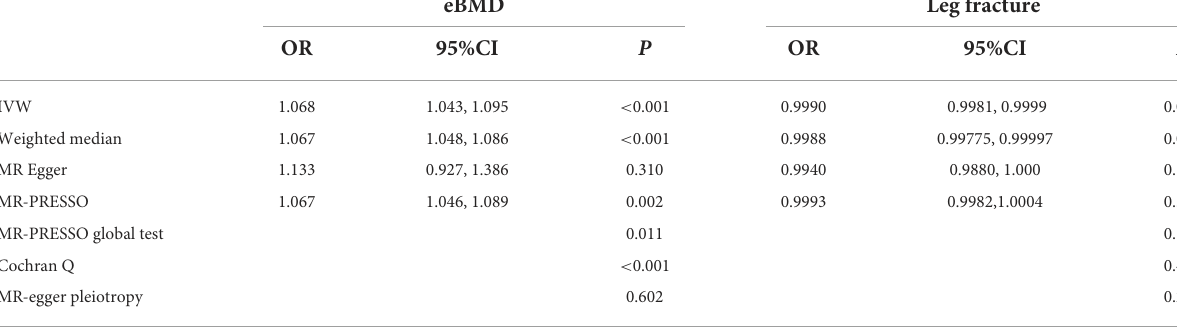
TABLE 1 Univariable MR results for childhood obesity on eBMD and leg fracture